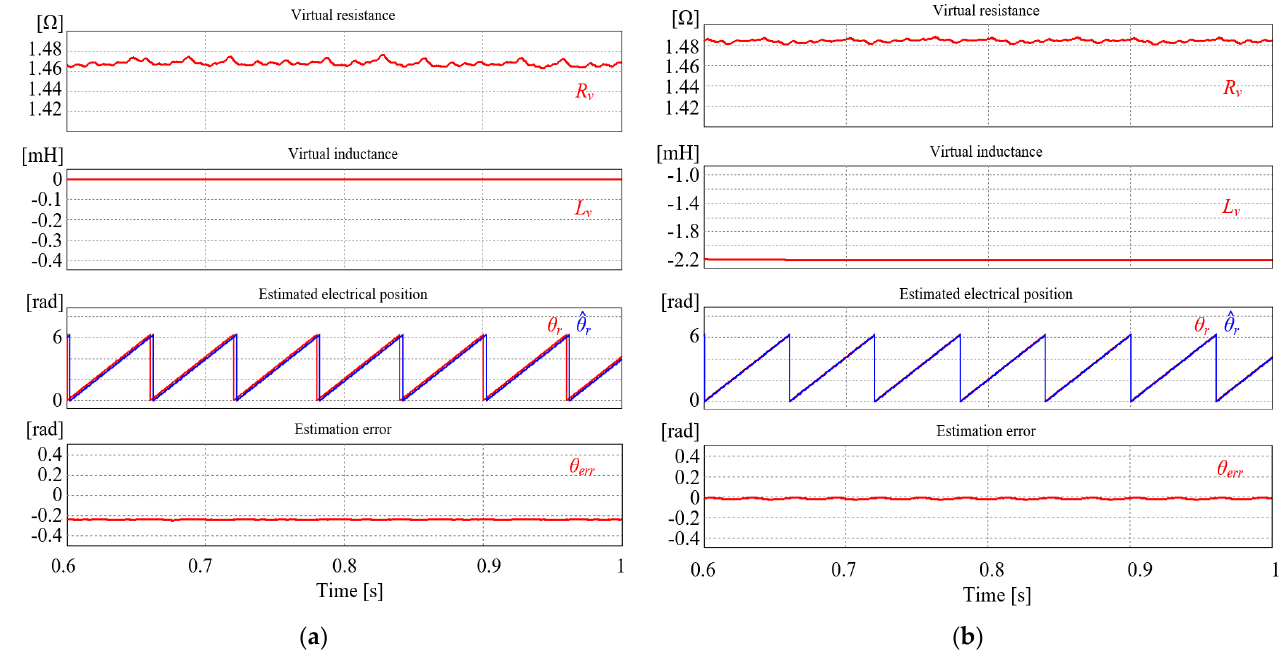
Figure 11. A magnified comparison of the conventional flying start method and the proposed flying start method with added VI at 500 rpm. ( a ) The conventional method and ( b ) the proposed method.